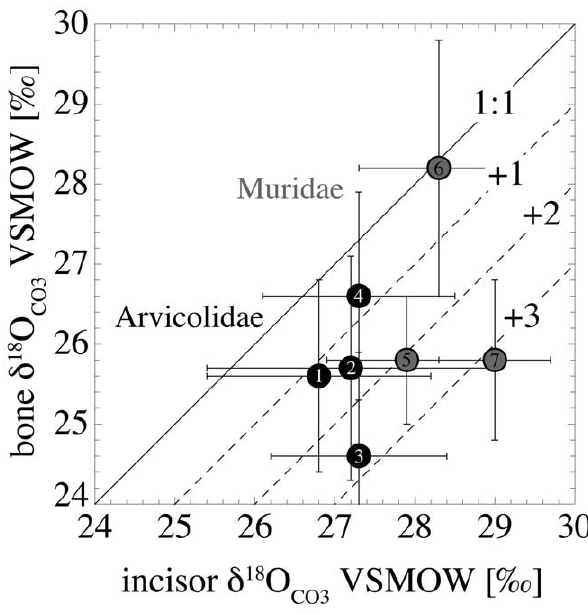
Figure 4. Comparison of incisor and bone d 18 O CO3 values from the individuals where both tissues were analysed (n=5 in each species). 1: A . terrestris , 2: M . glareolus , 3: M . agrestis , 4: M . arvalis , 5: A . sylvaticus , 6: M . musculus , 7: R . norvegicus . The dashed lines represent the deviation of incisor mean values from bone mean values in % from the 1:1 line (solid line).